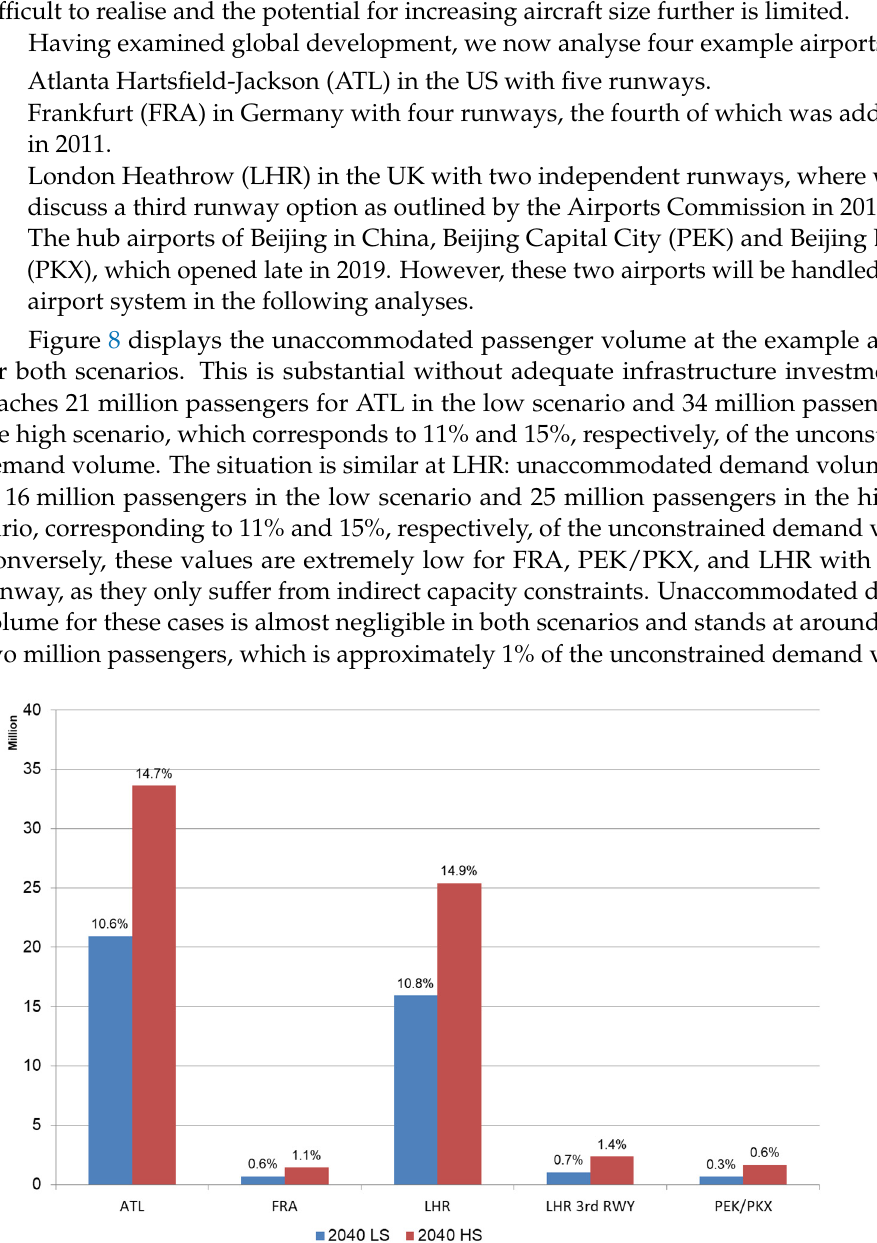
Figure 8. Unaccommodated passenger volume of the sample airports for 2030 and 2040 (values above the columns represent the share of unaccommodated passenger volume that forms part of the unconstrained passenger volume)